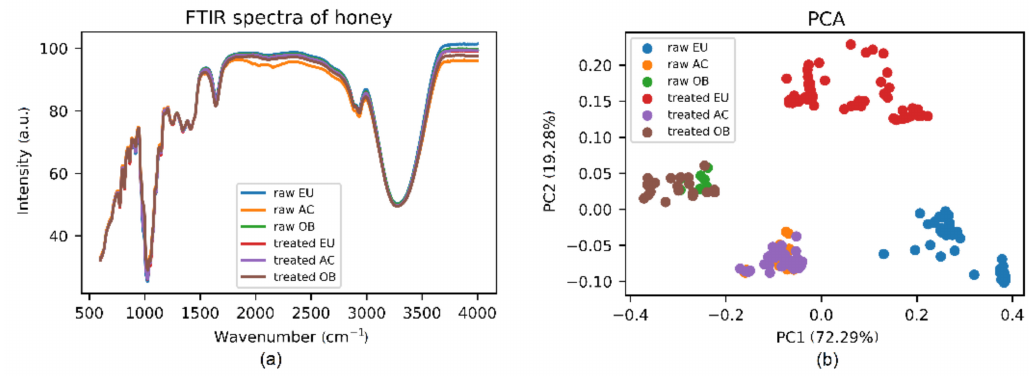
Figure 1. Raw and thermally treated honey samples—120 min at 70 ◦ C. ( a ) FTIR spectra. ( b ) Principal component score plot based on PCA (principal component analysis) applied to the spectral range of 600–4000 cm − 1 from FTIR data. EU: eucalyptus, AC: acacia, OB: orange